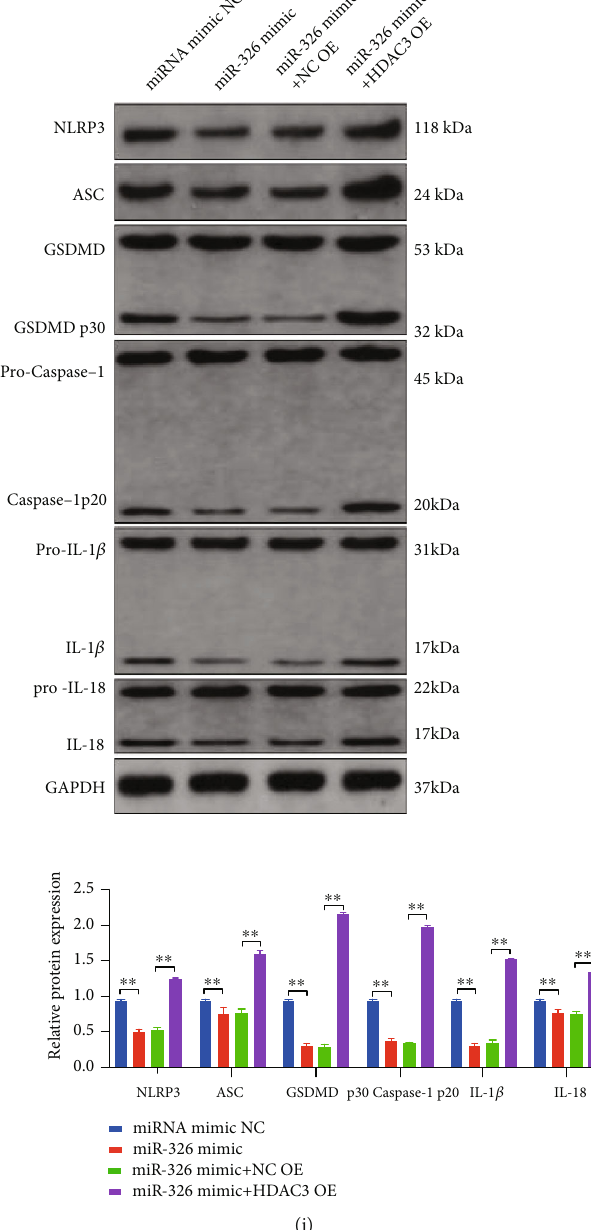
Figure 5: MiR-326 inhibited chondrocyte pyroptosis by targeting HDAC3 and activating the STAT1/NF- κ B p65 signaling pathway. (a) Overexpression of HDAC3 could counteract the accelerated proliferation of OA chondrocytes induced by miR-326 mimics; (b) overexpression of HDAC3 could counteract the enhanced migration of OA chondrocytes induced by miR-326 mimics; (c) overexpression of HDAC3 could counteract the increased mRNA levels of chondrogenic genes (COL2A1, SOX9, Agg, and Prg4) induced by miR-326 mimics in OA chondrocytes; (d) the dual luciferase gene report con fi rmed the targeting relationship between miR-326 and HDAC3; (e) overexpression of HDAC3 could reverse the reduction of proin fl ammatory factors (IL-1 β , IL-18, IL-6, and TNF- α ) in OA chondrocyte culture medium induced by miR-326 mimics; (f) Overexpression of HDAC3 could reverse the decrease of DNA-binding activity of NF- κ B p65 in OA chondrocytes induced by miR-326 mimics; (g) overexpression of HDAC3 could reverse the decrease of Caspase-1 activity in OA chondrocytes induced by miR-326 mimics; (h) immuno fl uorescence results showed that overexpression of HDAC3 could reverse the decrease level of GSDMD and cleaved Caspase-1 in OA chondrocytes induced by miR-326 mimics; (i) Western blot results showed that overexpression of HDAC3 could counteract the activation of STAT1/NF- κ B p65 signaling pathway in OA chondrocytes induced by miR-326 mimics; (j) Western blot results showed that overexpression of HDAC3 could reverse the decrease level of pyroptosis-related proteins (NLRP3, ASC, GSDMD, Caspase-1, IL-1 β , and IL-18) in OA chondrocytes induced by miR- 326 mimics; ∗ P < 0 : 01 , ∗∗ P < 0 : 01